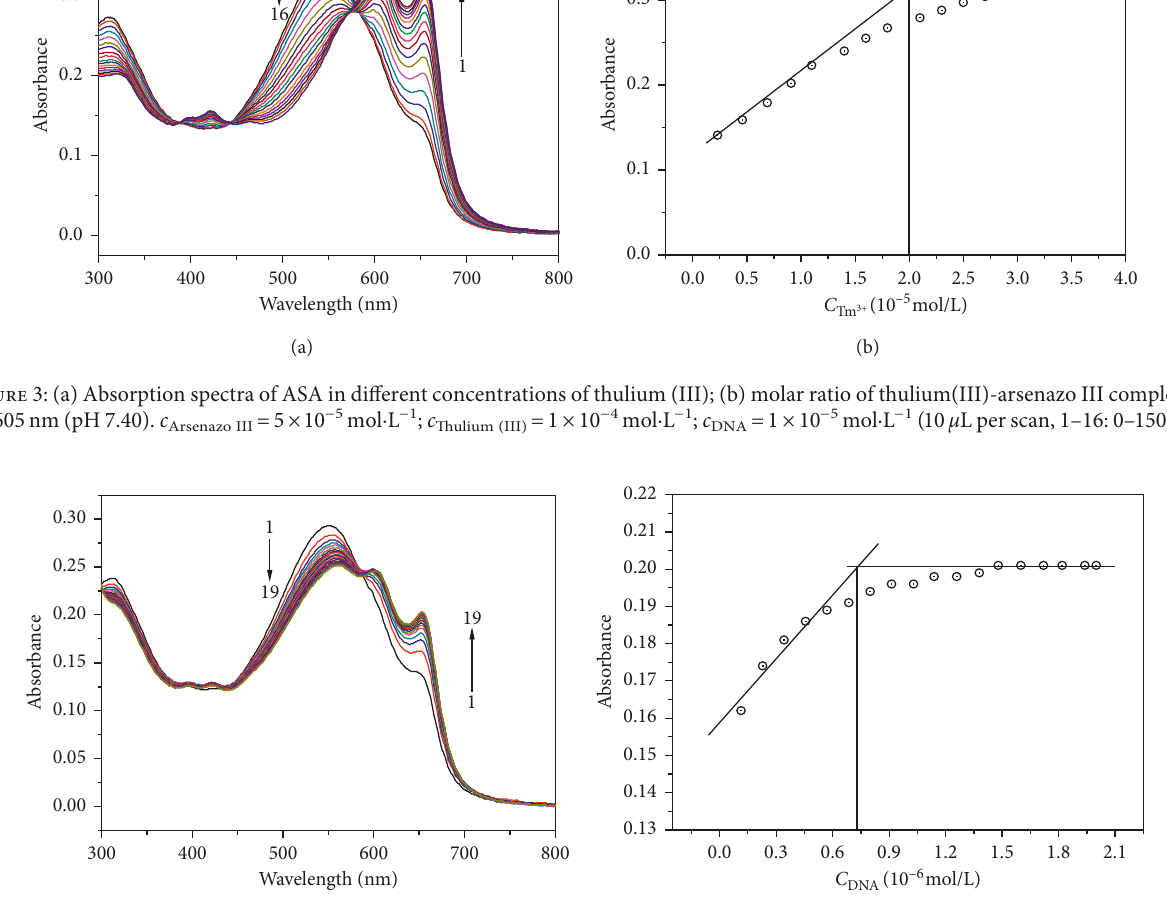
Figure 4: (a) Absorption spectra of thulium(III)-arsenazo III complex in different concentrations of DNA; (b) molar ratio of DNA-thulium (III)-arsenazo III system at λ